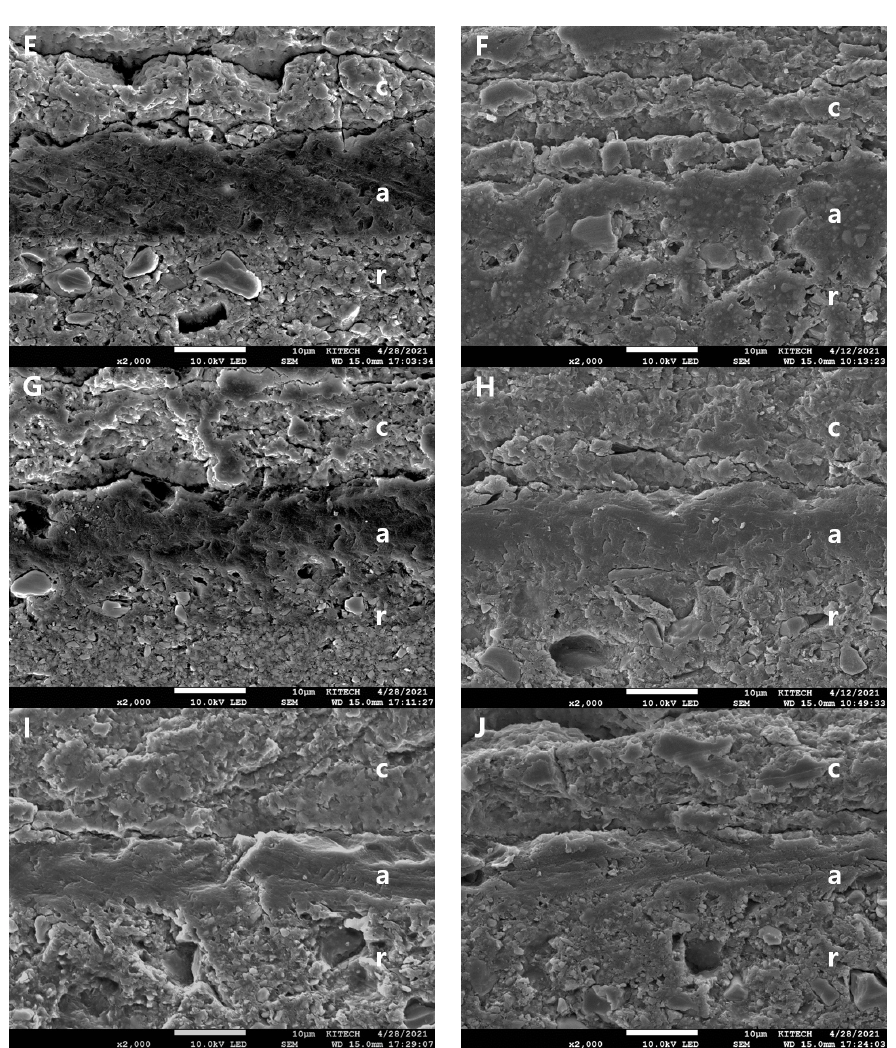
Figure 7. Comparison of the SEM images (×2000 magnification) of the interfaces between ceramic and resin cement in the specimens. ( A ) HF only, ( B ) HF and silane, ( C ) HF and ABU, ( D ) HF, silane, and ABU, ( E ) HF and PB, ( F ) HF, silane, and PB, ( G ) HF and SBU, ( H ) HF, silane, and SBU, ( I ) HF and CU, ( J ) HF, silane, and CU. c = ceramic, a = adhesive, r = resin cement.